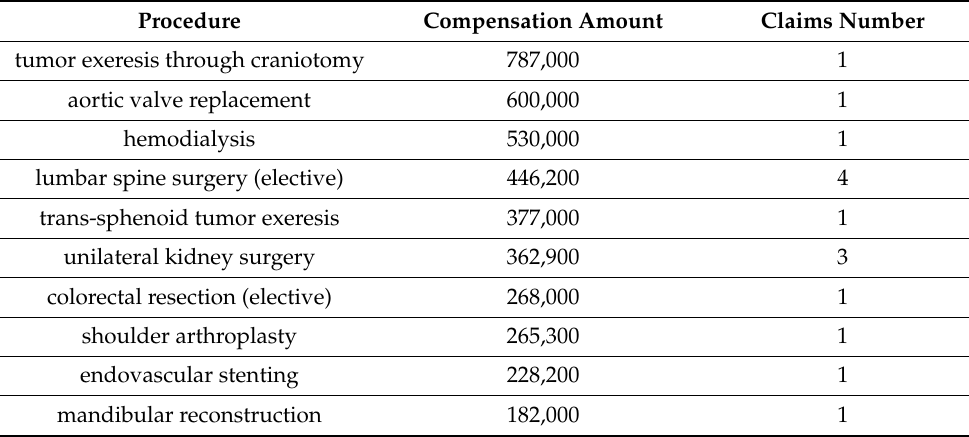
Table 6. Compensation amount per kind of invasive